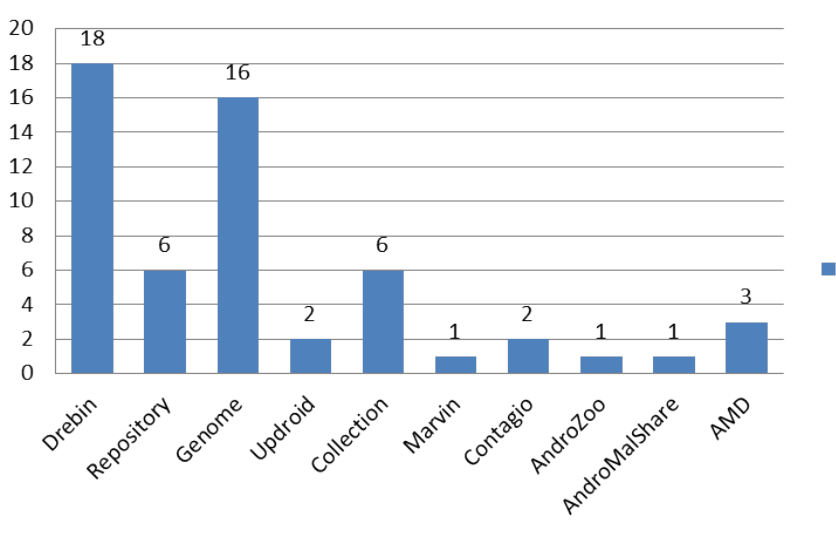
Figure 2. Popular Android malware datasets.